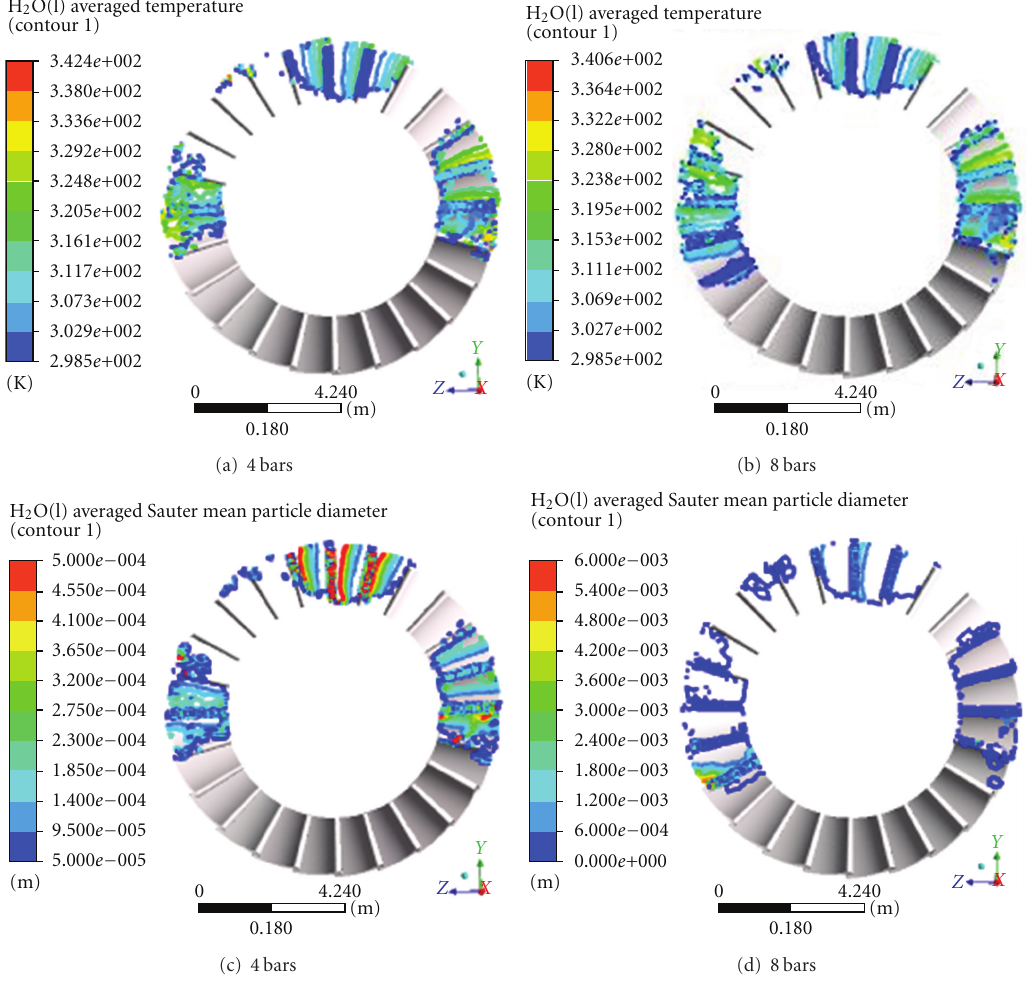
Figure 5: Numerical predicted water droplet temperature and size distributions on blade surface at a loading speed of 800 rpm/T ∧ 0.5 for water injection pressures of 4bars and 8bars, respectively, and 90 ◦ water nozzle angle without a